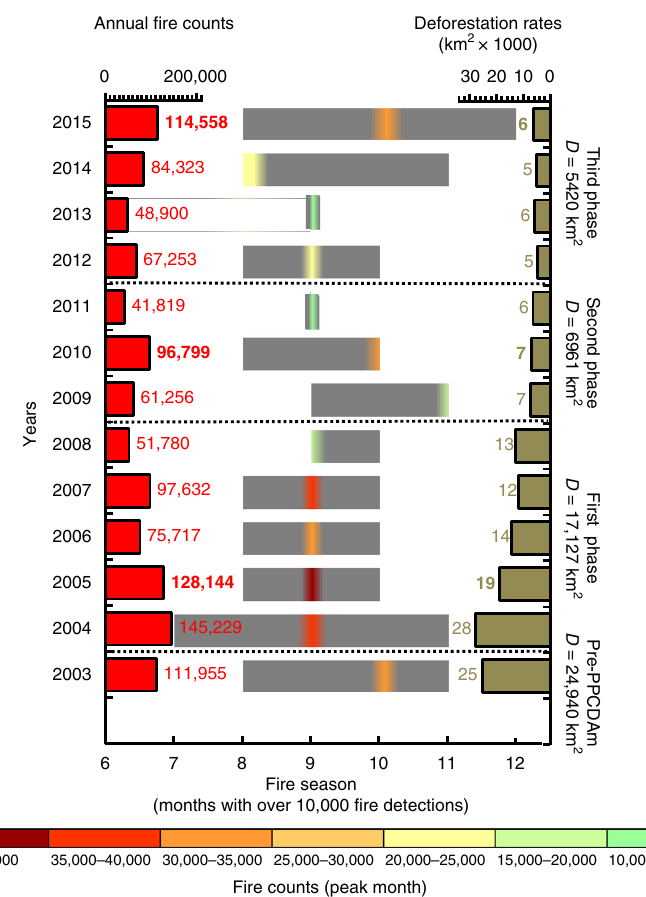
Fig. 5 Annual fi re behaviour in the Brazilian Amazon. Fire season estimated as the months with over 10,000 fi re detections. Numbers in the x -axis correspond to the fi re season months from June (month 6) to December (month 12). The length of the grey bars corresponds to the sum of all months with fi re above the threshold. Colours inside of grey bars indicate the number of active fi res detected during the peak fi re month. Red bars on the left indicate the absolute number of annual fi res detected and dark green bars on the right are depicting the total area deforested (km 2 yr − 1 ) for each year within the limit of the Brazilian Amazon biome. Dashed lines separate the phases of the Action Plan for Prevention and Control of Deforestation in Amazonia (PPCDAm). Numbers over the bars in bold correspond to the drought